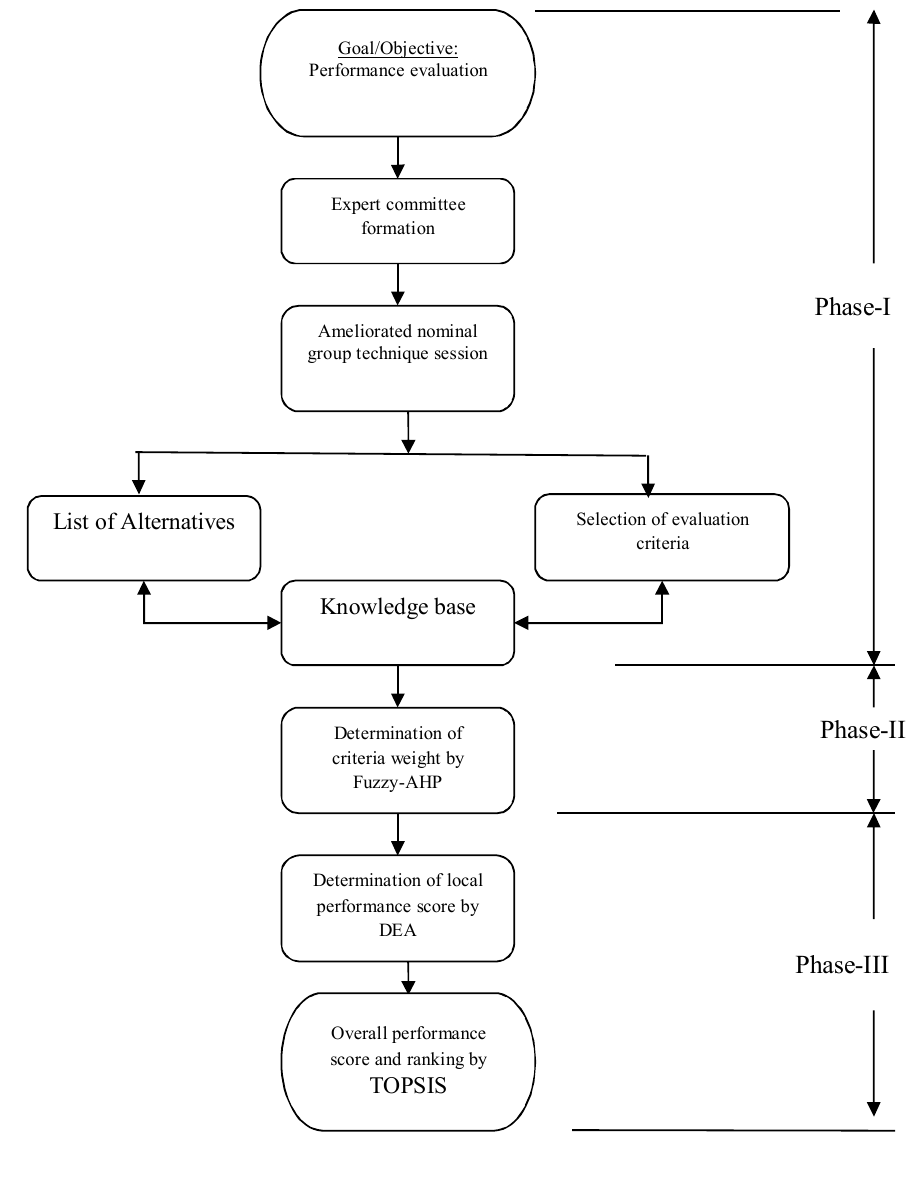
Fig. 2. Schematic view of the proposed